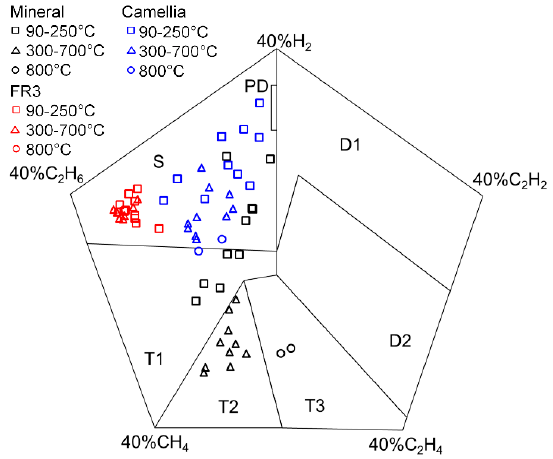
Figure 18. Diagnostic results of simulated thermal faults using the Duval Pentagon (data in the figure are expressed as a function of oven temperature).